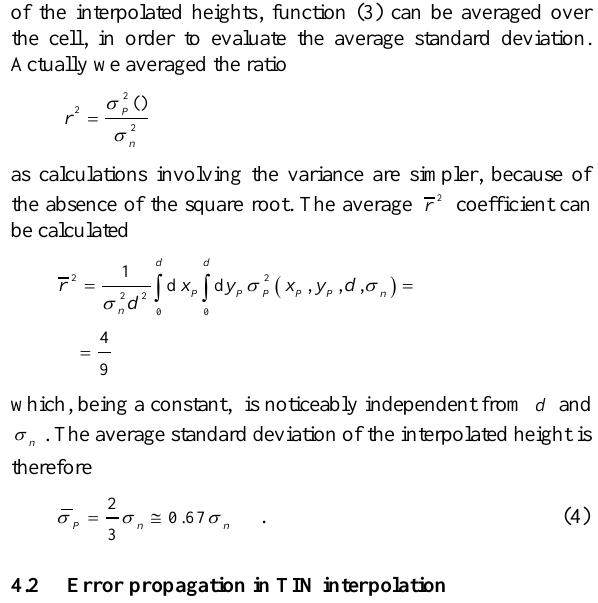
TIN interpolation is now studied. The considered triangle is shown in Figure 3 and has one vertex in the origin and another one on the X